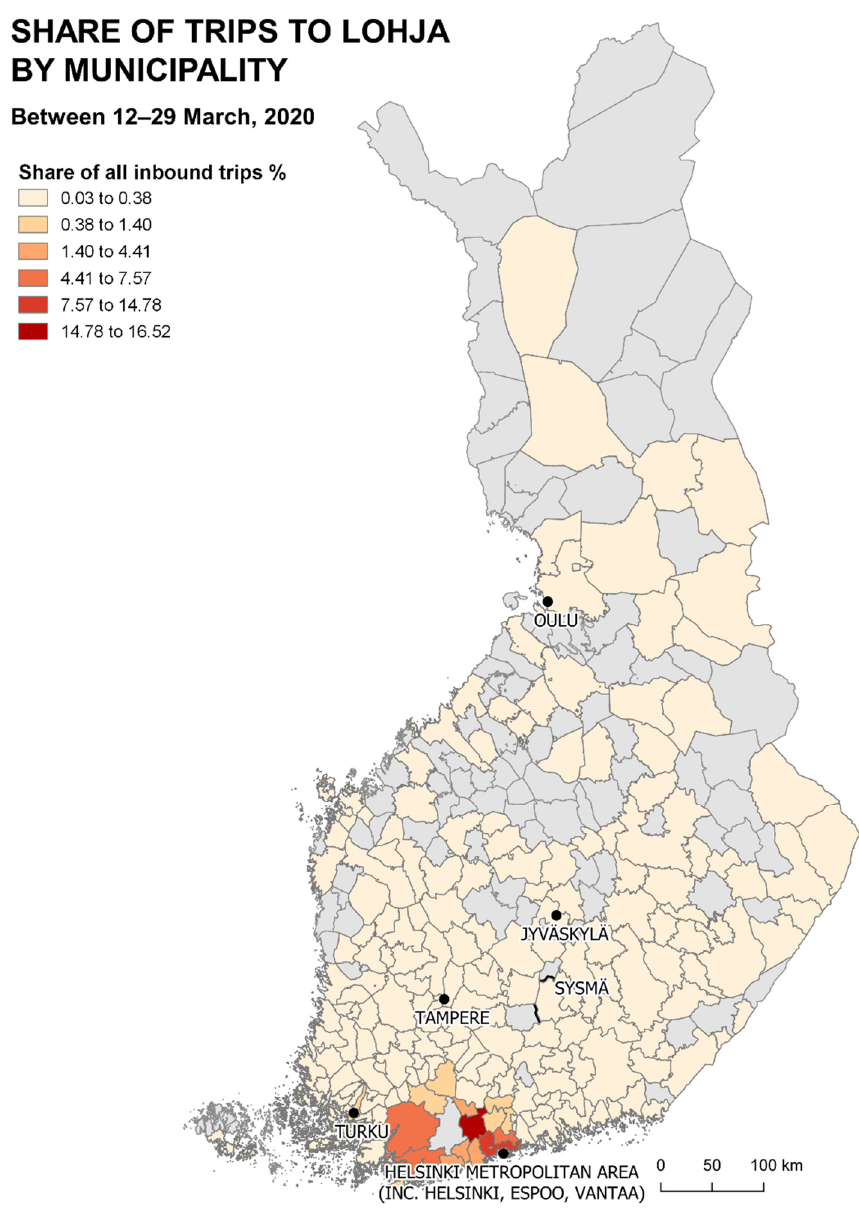
Figure A3. Incoming trips to Lohja by municipality on 12–29 March, 2020, based on Telia trip data.